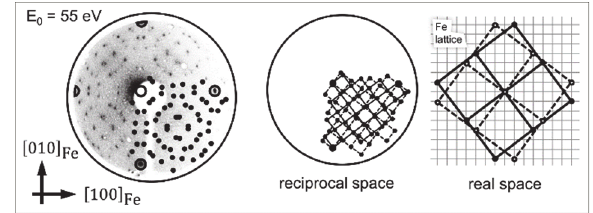
Fig. 1. LEED image for 1 ML of CoTPP on Fe(001)- p (1 × 1)O. Diffraction spots are marked with dots (large open dots are representative of the diffraction pattern from the substrate). The two domains contributing to the overall signal from CoTPP molecules are sketched next to the LEED image, both in reciprocal and real space. In the latter case, a finer grid is superimposed to the CoTPP lattice, representative of the Fe(001) surface lattice.